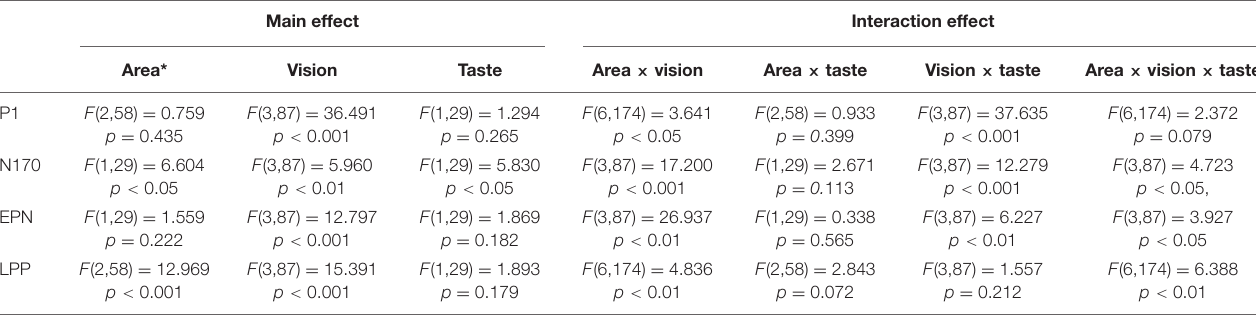
FIGURE 3 | Panels (A–D) represent the average response amplitude of P1, N170, EPN, and LPP, respectively. X-axis represents the eight different stimuli combinations, and Y-axis represents the average amplitude in µ v. The gray dots, black dots, and black squares represented the left, mid, and right brain responses, respectively. TABLE 2 | Results of the analyses of variance for the ERP component P1, N170, EPN, and